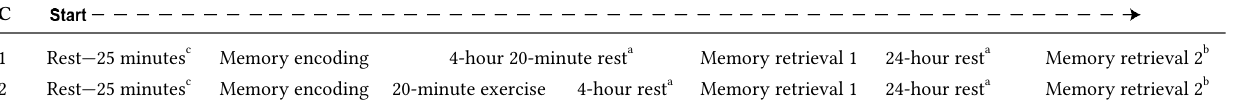
Study Protocol for Experiment 2